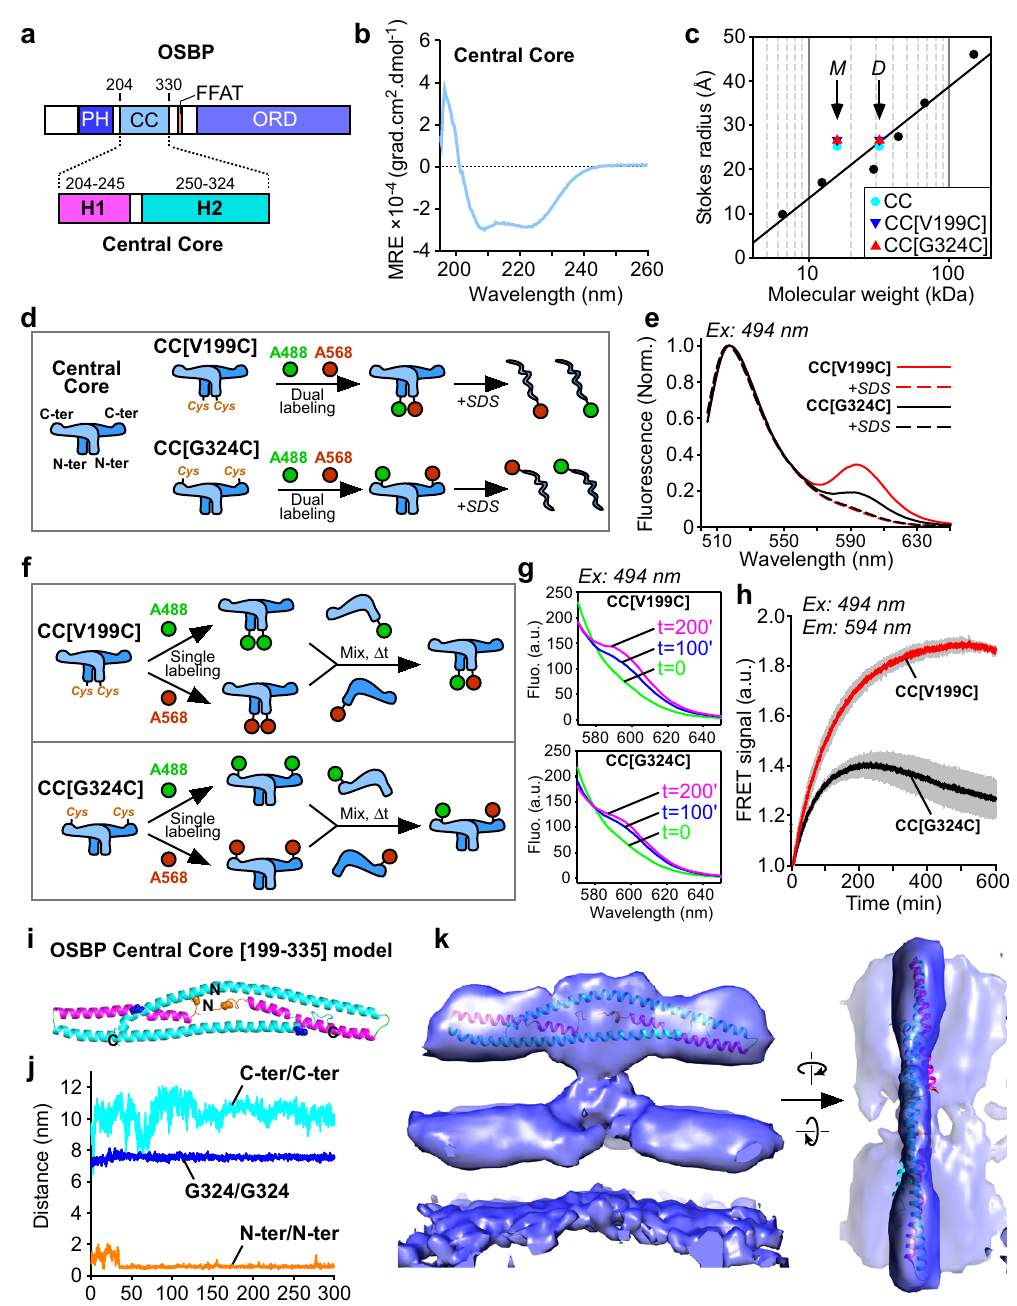
Fig. 5 3D architecture of the central core domain of OSBP. a Domain organization of OSBP with its central core (CC) region and the predicted H1 and H2 helices. b Circular dichroism spectroscopy of OSBP CC region. Circular dichroism CD spectra minima at 208 and 222 nm indicative of signi fi cant α - helical content. c Stokes radius versus MW of OSBP CC constructs (WT, light blue dot; V199C/C224A/C276A, blue triangle; C224A/C276A/G324C, red triangle) and standards (black dots) as determined by gel fi ltration. The arrows indicate the expected positions for monomers (M) or dimers (D) according to their MW. d Principle and ( e ) spectra of dual labeled AF-488 and AF-568 OSBP CC on the N-ter (V199C) or the C-ter (G324C) region analyzed by fl uorescence resonance energy transfer (FRET). FRET signal vanished after dissociation of dimers of OSBP CC region with SDS. f Principle of OSBP CC monomer exchange experiment as analyzed by FRET g spectra and h kinetics analyses of monomer exchange between mono labeled AF- 488 and mono labeled AF-568 OSBP CC region. Labeling was performed and a Cys introduced either on the N-ter (V199C) or the Cter (G324C) of a construct having endogenous Cys substituted to Ala (C224A/C276A). i Structure of the dimer OSBP CC after 300 ns MD simulation colored by chains. j Plot of the distances between C-termini, N-termini, and G324/G324 along the MD trajectory (300 ns). k Fit of the dimer OSBP CC after 300 ns MD simulation in the 3D EM model of N-PH-FFAT. A representative result is from at least three